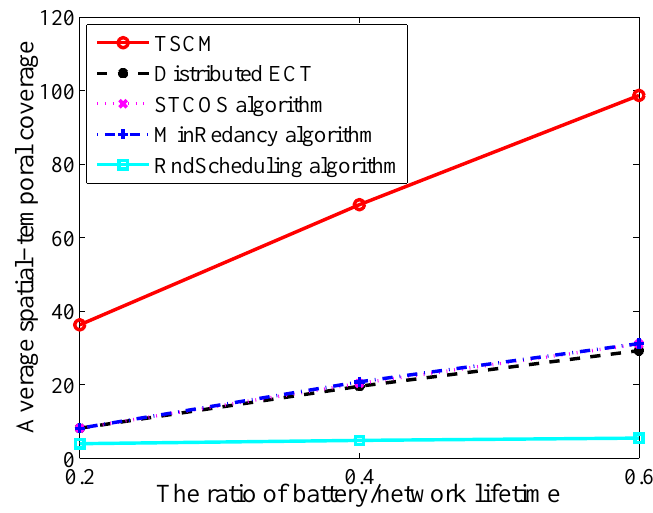
Figure 7. The average spatial-temporal coverage versus different number of targets.